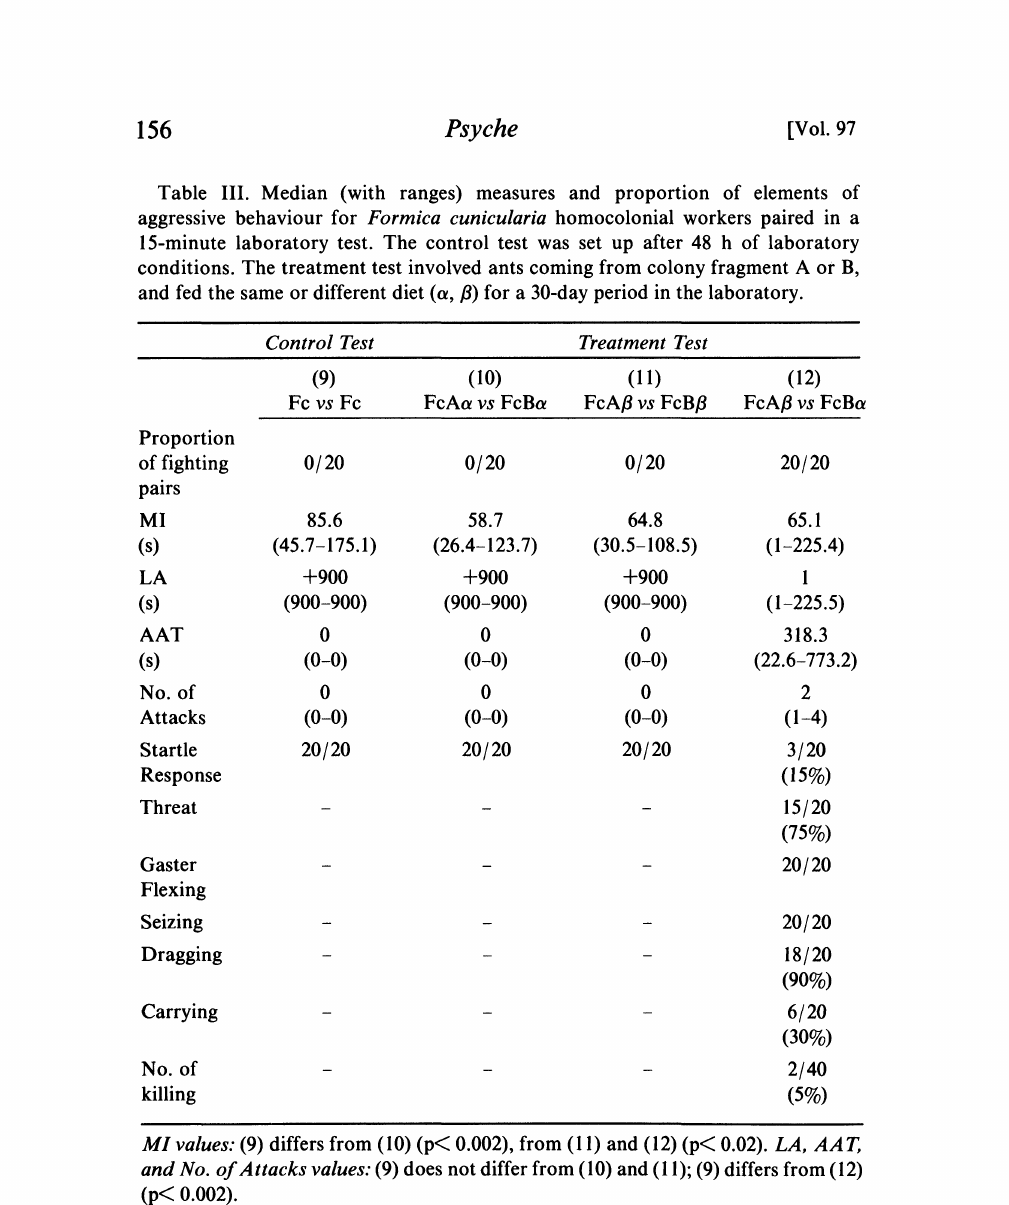
Table III. Median (with ranges) measures and proportion of elements of aggressive behaviour for Formica cunicularia homocolonial workers paired in a 15-minute laboratory test. The control test was set up after 48 h of laboratory conditions. The treatment test involved ants coming from colony fragment A or B, and fed the same or different diet (tz, fl) for a 30-day period in the